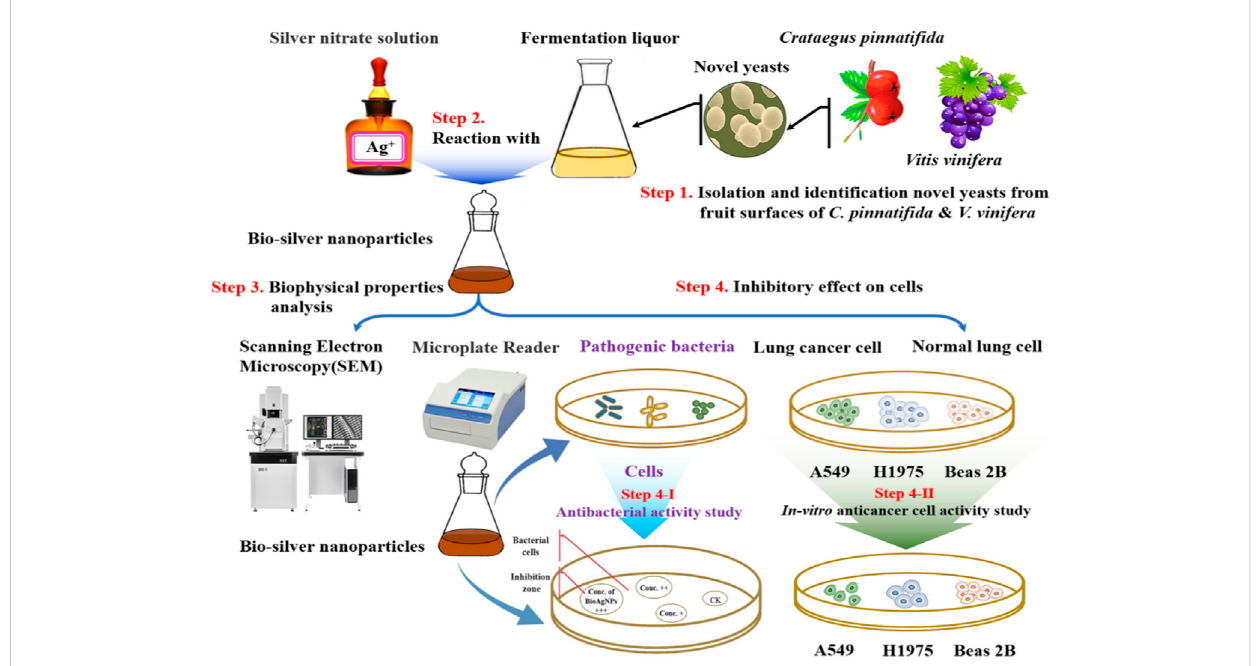
FIGURE 5 Experimental diagram of the synthesis of Ag nanoparticles from the yeast strain. Adapted from (Liu et al. 2021) CC BY license. Various steps include isolation of two yeast strains, HX-YS and LPP-12Y, and analysis oftheir activityon the human lung cancer cell lines A549 and H1975, as well as thenormal human lung epithelial cell line Beas